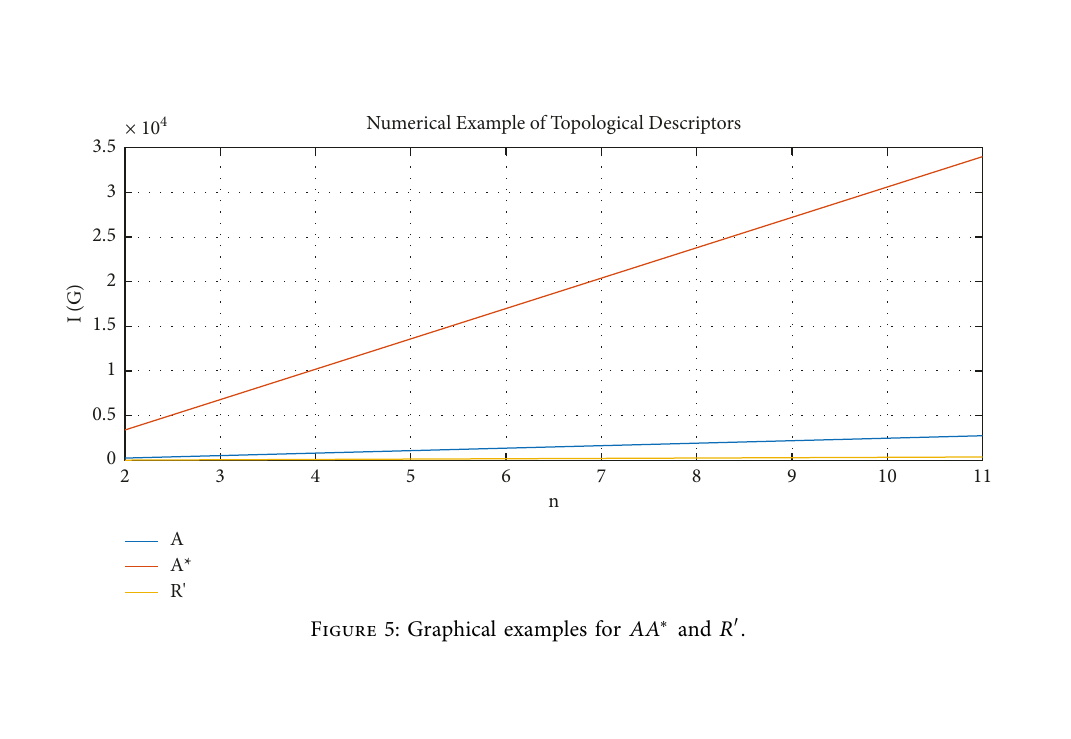
Figure 5: Graphical examples for AA